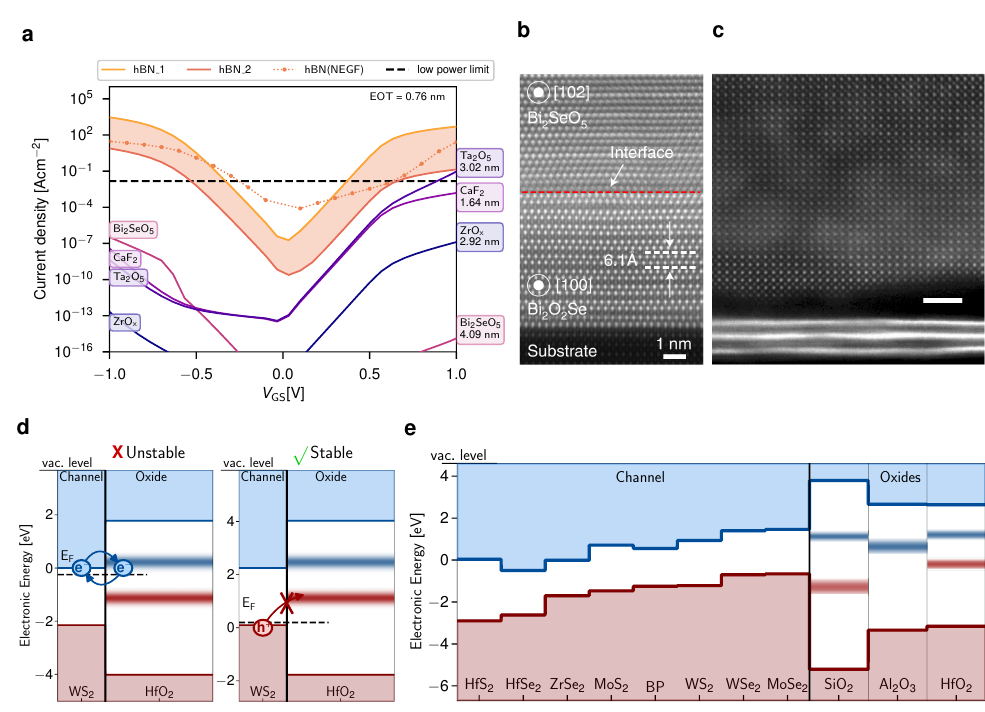
Figure 4. ( a ) Calculated gate leakage current densities through a MOS structure formed by a gold metal contact, various gate insulators, and a silicon channel. The currents are compared as a function of the applied gate voltage for a scaled EOT of 0.76nm and were calculated based on the Tsu-Esaki model. The orange range indicates the interval of possible currents through hBN spanned by two different sets of effective masses and the dotted orange line shows the DFT+NEGF results. The leakage currents through hBN exceed the leakage currents through native oxides or ionic insulators by many orders of magnitude. Reproduced with permission from T. Knobloch et al., IRPS, 2A.1, 2022; published by the IEEE [76]. ( b ) Cross-sectional high-angle annular dark-field (HAADF) TEM image of the interface between the semiconductor Bi 2 O 2 Se and its native oxide Bi 2 O 5 Se, after few minutes of oxidation at 380°C. An atomically sharp Van der Waals interface between both compounds is formed during oxidation. Reproduced with permission from T. Li et al., Nature Electronics 3, 473-478, 2020; published by Springer Nature [70]. ( c ) HAADF TEM image of the interface formed when transferring a thin crystalline SrTiO 3 on top of few-layers of MoS 2 , scale bar 2nm. Reproduced from A. Yang et al., Nature Electronics 5, 233–240, 2022e [72]. ( d ) If the conduction band edge of the 2D semiconductor is close to a charge trapping band in the oxide, charge trapping events are frequent and the FET is electrically unstable. This is shown in the band diagram of n-type WS 2 and its alignment to the electron trapping band in HfO 2 . For p-type WS 2 , however, the FET will be more stable. ( e ) Band diagram of various 2D semiconductors with the three most commonly used amorphous oxides, indicating good stability, for example for black phosphorous (BP) or hafnium disulfide (HfS 2 ) FETs with HfO 2 as a gate insulator. ( d , e ) reproduced from T. Knobloch et al., Nature Electronics 5, 356–366, 2022